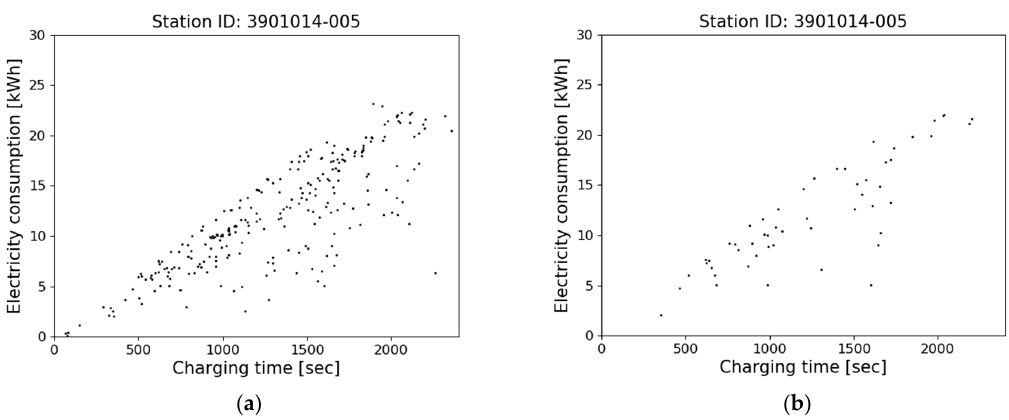
Figure 11. Electricity consumption distribution according to charging time for sample charging station ( a ) from April 2017 to June 2017 and ( b ) at June 2017.